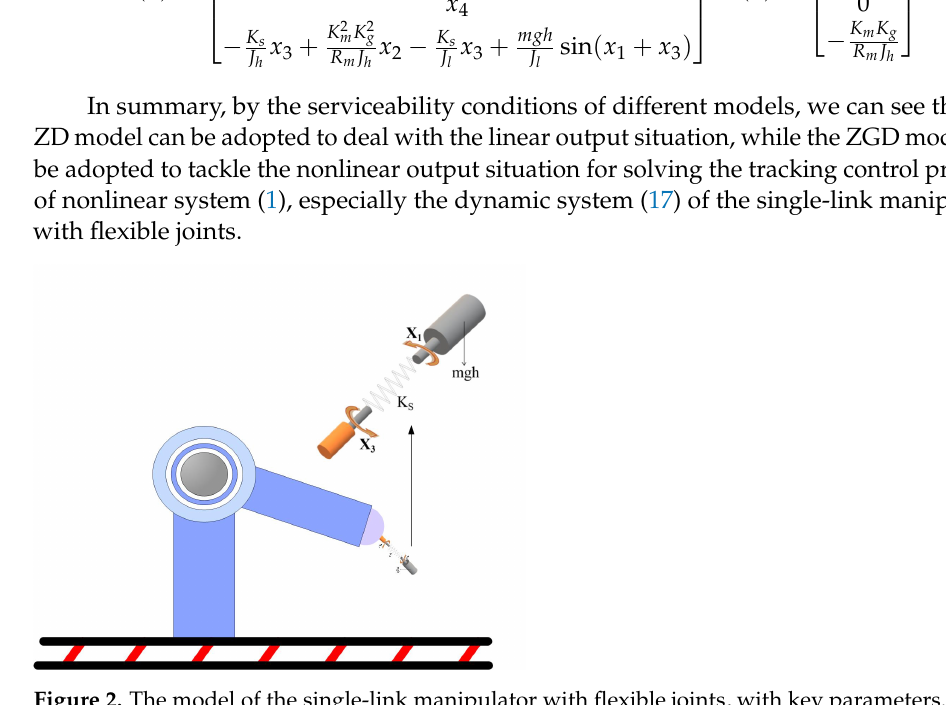
Figure 2. The model of the single-link manipulator with flexible joints, with key